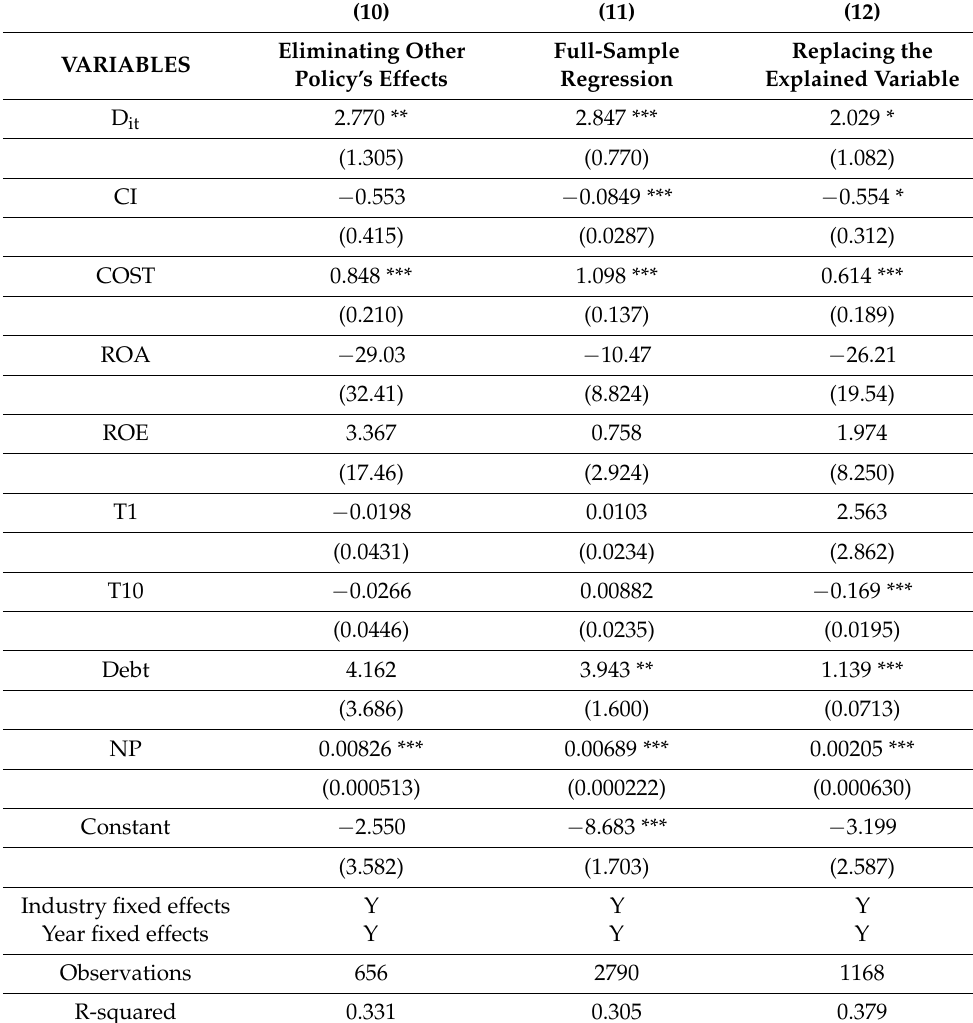
Table 5. Results of robustness